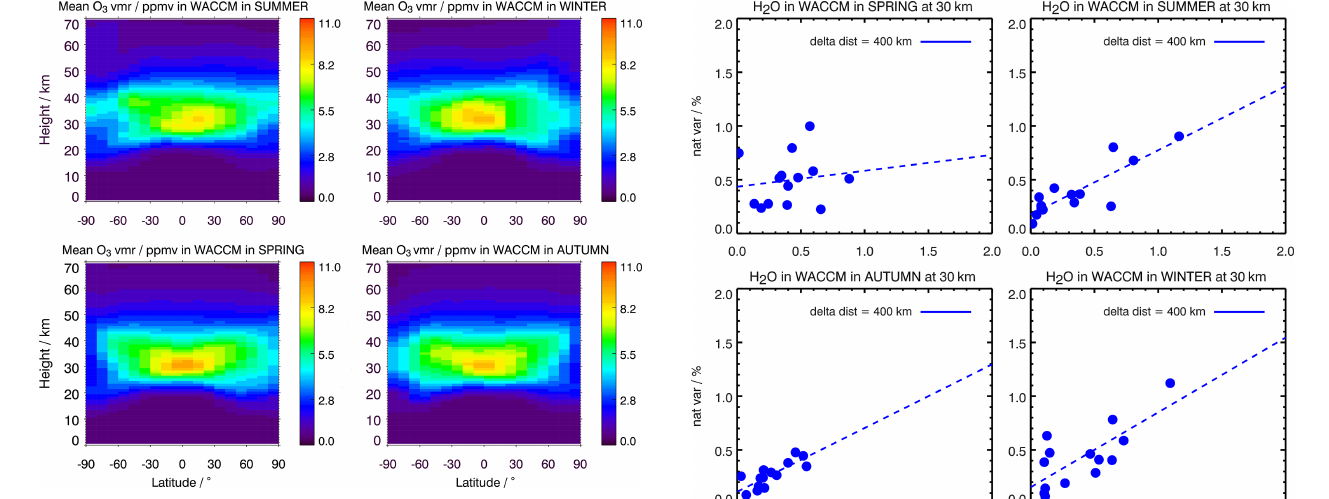
Figure 5. Distribution of O 3 in 1 week of each season in the WACCM model.